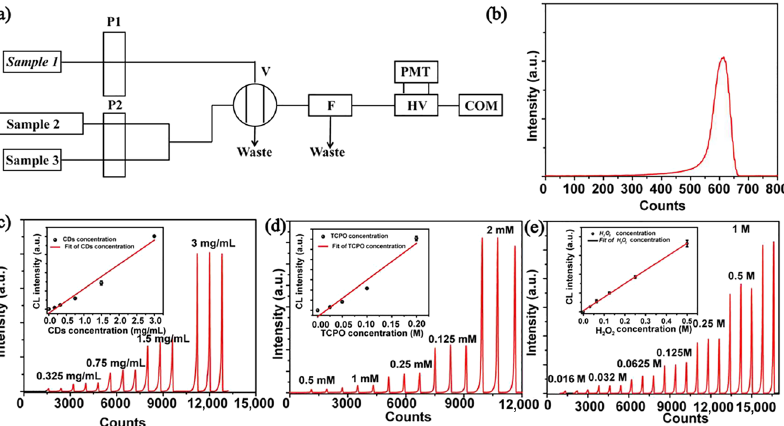
Figure 3: (a) Schematic illustration of the structure of flow-injection CL analysis in- strument. (b) One cycle with 3 mg mL − 1 CDs, 2 mM TCPO and 1 M H 2 O 2 as samples. (c – e) The CL signal curve induced by different concentration of CDs (c), TCPO (d), and H 2 O 2 (e) (insets: fi tted curve of the maximum CL intensity vs. the concentra- tion), error bars represent the standard deviation for three measurements.